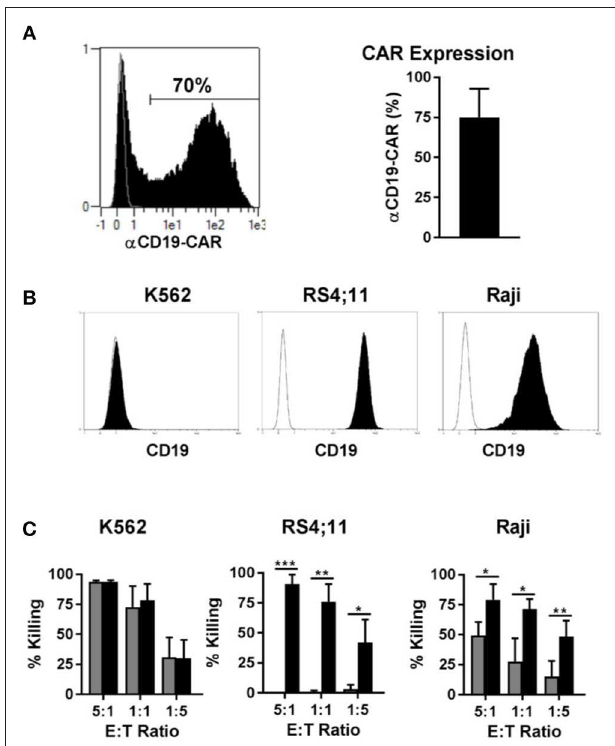
FIGURE 7 | Transduction of NK cells with BaEV pseudotyped vector allows high expression of CD19-CAR and increased CAR specific cytotoxicity. Activated NK cells were transduced with BaEV pseudotyped LV for expression of a CAR directed against CD19, or the cells were left non-transduced as a control. The aCD19-CAR expression of transduced cells (black) or non-transduced cells (gray) was measured by FACS and is shown in an exemplary histogram for 1 donor ( A left) and a bar chart for mean and SD of 4 donors from different experiments ( A right). Different target cells were stained for CD19 (black) or an isotype control (white) and analyzed by flow cytometry (B) . Killing of three target cell lines by aCD19-CAR expressing NK cells (black) or non-transduced NK cells (gray) from four different donors were analyzed at different effector-to-target ratios in different experiments and mean and SD are displayed (C) . * P ≤ 0.05, ** P ≤ 0.005, *** P ≤